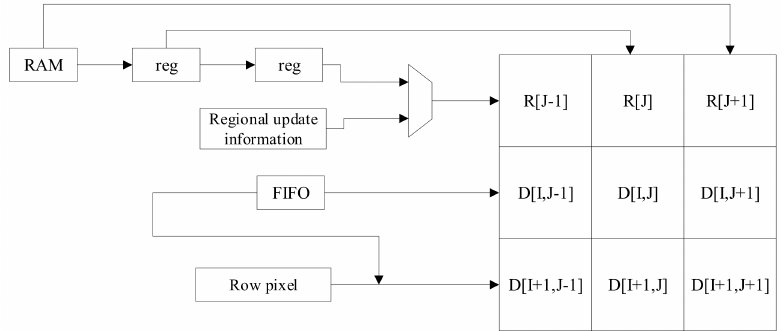
Figure 12. Heterogeneous convolution